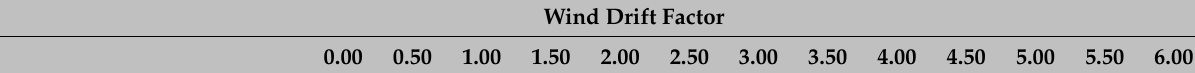
Table 2. RMSE and skill score of the Lagrangian model for the deployments of April